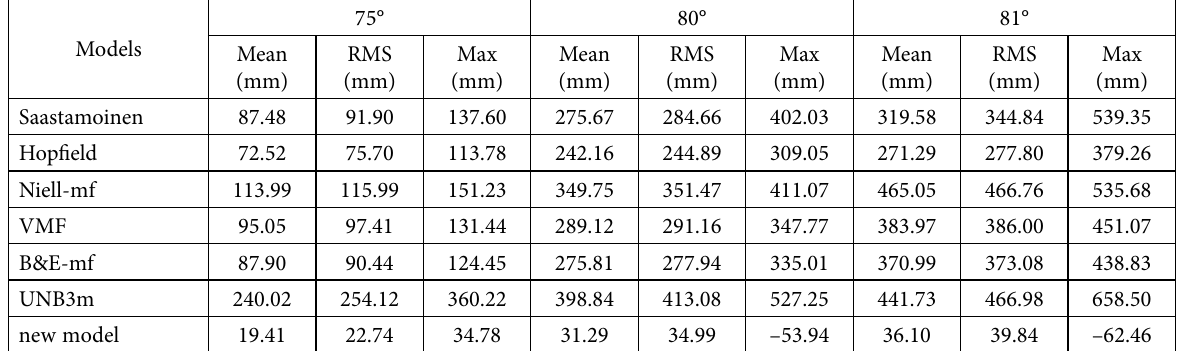
Table 5. Tropospheric delay difference (in mm) between different models and NIM